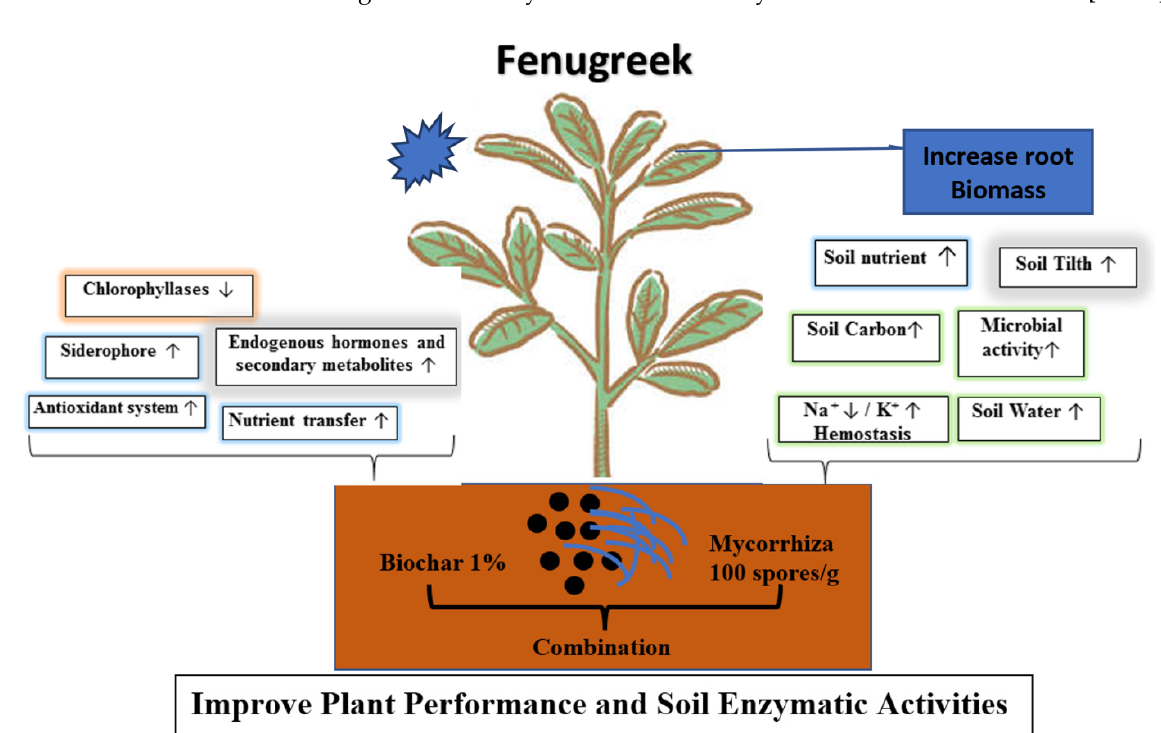
Figure 5. Summary of the mechanism of action for the joint impact of Biochar and AMF on plant development and soil enzymatic activity in the Fenugreek.